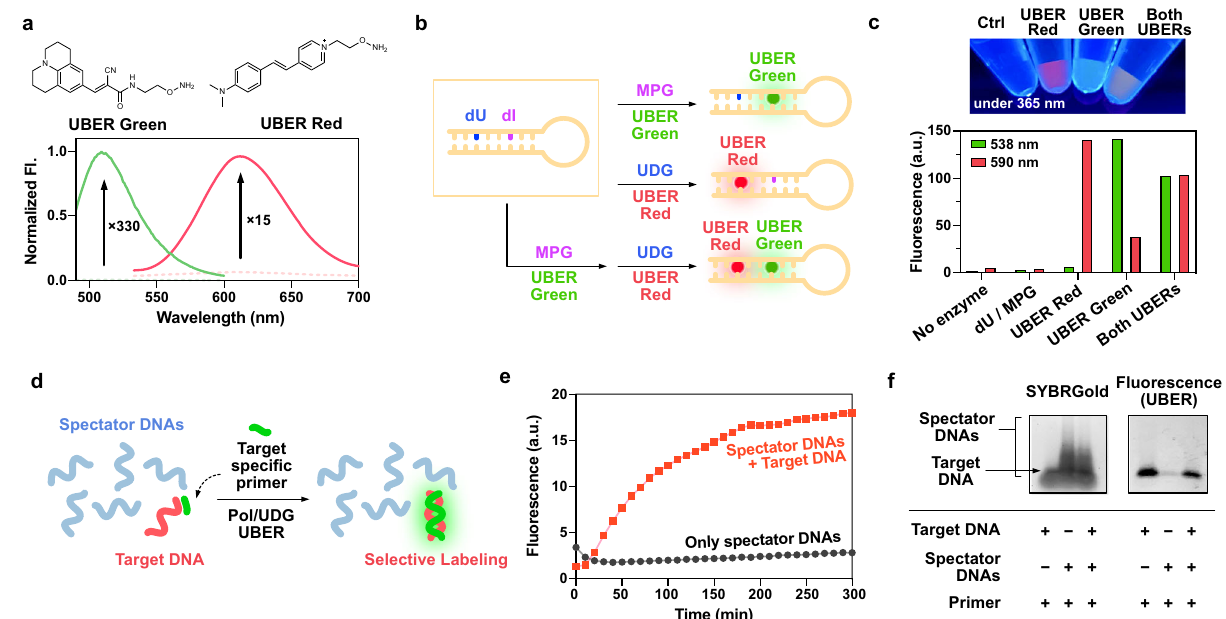
Fig. 3 | Two-color labeling, and selectivity on a target DNA. a Chemical struc- tures and fl uorescence spectrum of UBER Green and UBER Red showing enhancement in AP site. b Illustrational description of two-color labeling of a hairpin ODN containing two different DNA lesions with corresponding gly- cosylases. c A picture of UBER labeled ODNs puri fi ed by DNA precipitation taken on a gel illuminator with 365nm excitation, and fl uorescence intensities at 538 and 590nm while excited at 485nm. d Illustration of selective labeling of target DNA in the presence of spectator DNAs in the mix. e Fluorescence changes in the in situ synthesis and labeling of DNA in the presence of